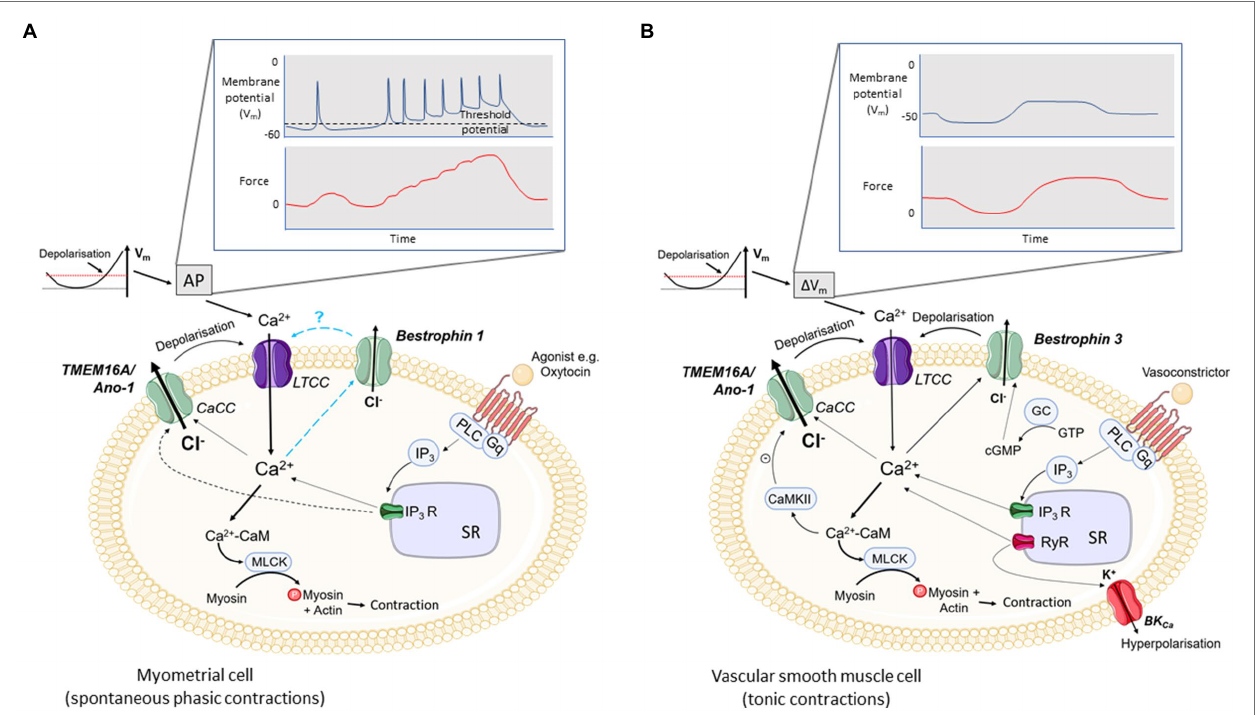
FIGURE 1 | Excitation-contraction coupling in uterine and vascular smooth muscle cells (VSMCs) and the potential roles for CaCCs. (A) In spontaneously active smooth muscles, e.g. myometrium, depolarisation of the membrane potential (V m ) to threshold initiates an action potential (AP) and phasic contractions. (B) In most vascular smooth muscles which are not spontaneously active, slow, tonic changes in V m give rise to tonic contractions. In both, depolarisation leads to opening of voltage-gated calcium channels (L-Type, LTCC) and calcium entry. Calcium binds to calmodulin and the Ca 2+ -CaM complex activates myosin light chain